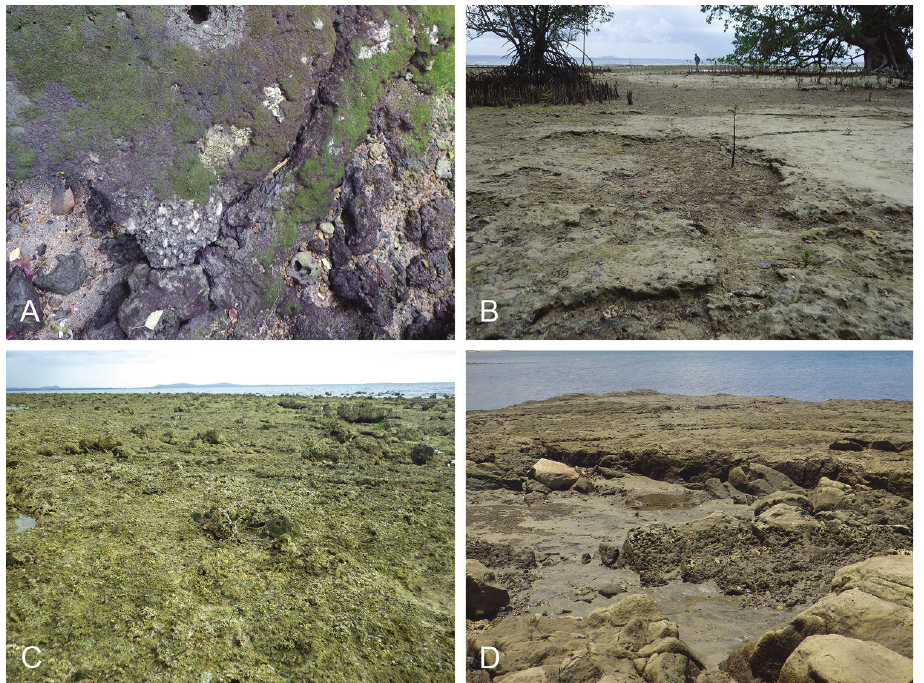
Figure 35. Coral rubble habitats, Wallaconchis ater . A Indonesia, Sulawesi, Bahoi, sand and small rocks outside a mangrove (st 88) B Philippines, Bohol, Maribojoc, uplifted, dead, coral flat covered with sand and algae adjacent to a few mangrove trees (st 202) C Philippines, Bohol, Maribojoc, coral rubble of uplifted coral reef (st 191) D Indonesia, Halmahera, Foli, rocky shore by beach (st